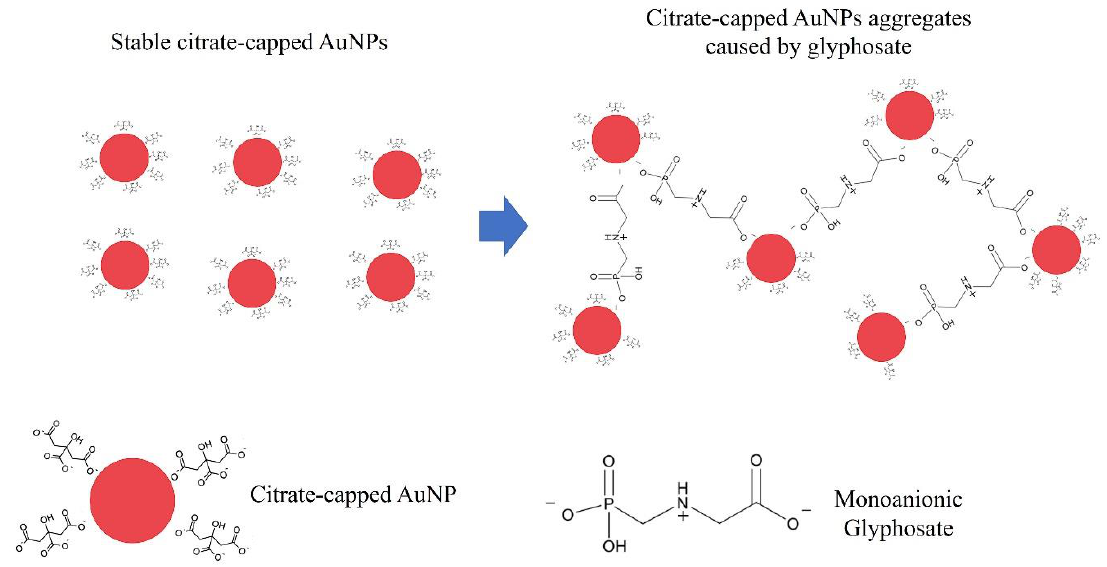
Figure 5. Schematic representation of the glyphosate detection strategy with citrate-capped AuNPs, not in scale.